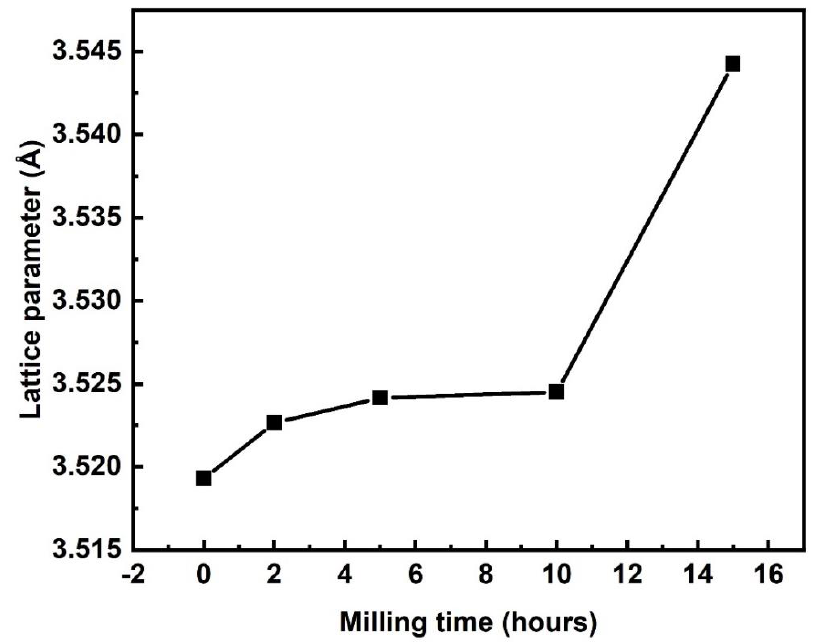
Figure 4. Variation of the true lattice parameter of 23Fe-21Cr-18Ni-20Ti-18Mn HEA powders with respect to milling time.